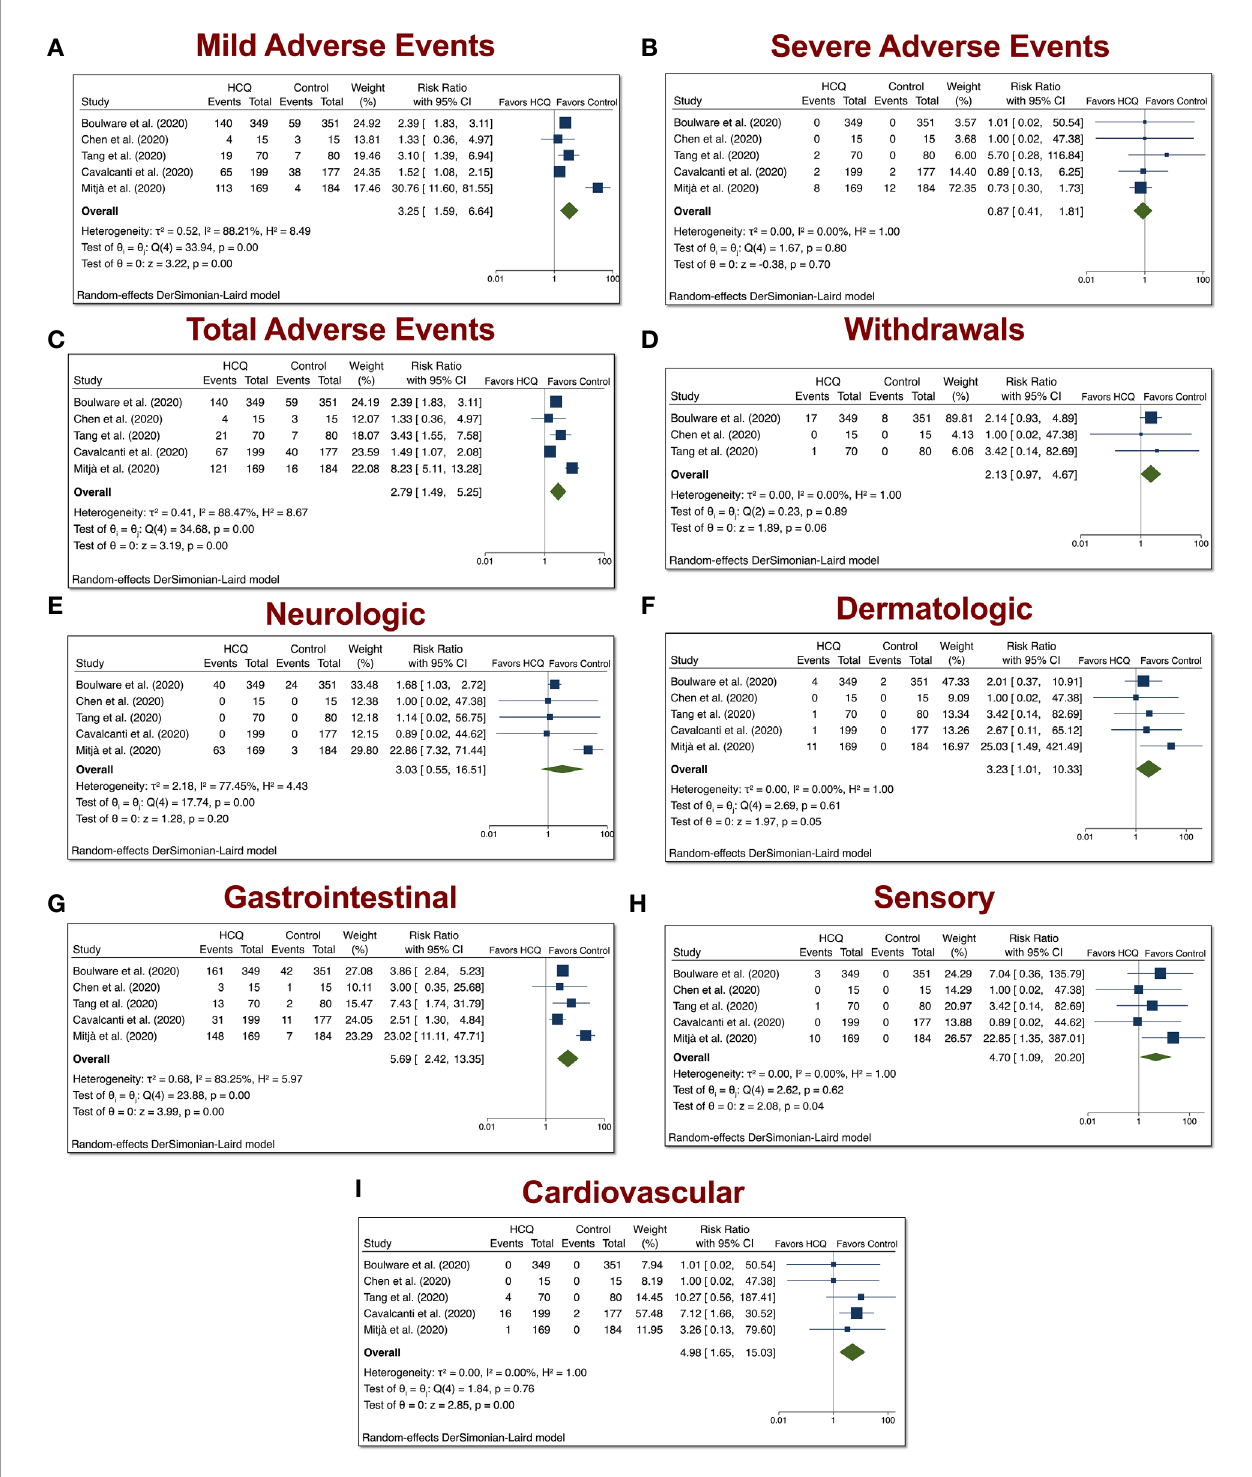
FIGURE 4 | Mild, severe, total AEs, and withdrawals due to AEs from COVID-19 studies involving HCQ. The HCQ meta-analyses of (A) mild, (B) severe, (C) total, (D) withdrawals due to AEs, (E) neurologic, (F) dermatologic, (G) gastrointestinal, (H) sensory, (I) and cardiovascular AEs were based on fi ve comparisons between HCQ and control in COVID-19